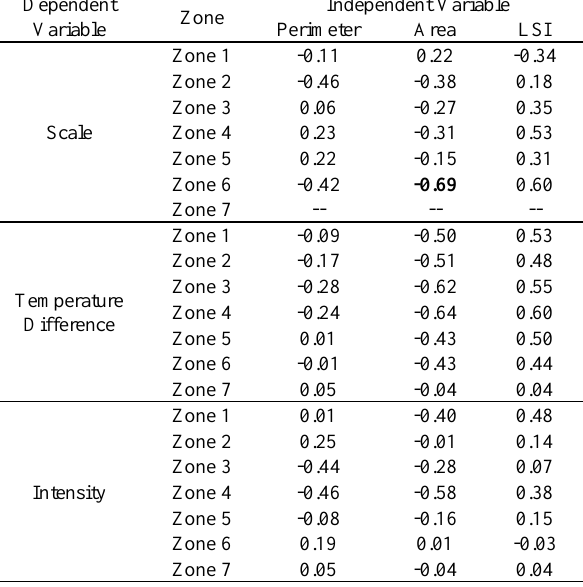
Table 5. Summary of Pearson correlation analysis between UCI indices and wetland spatial characteristics (r values in bold text are statistically significant with p <